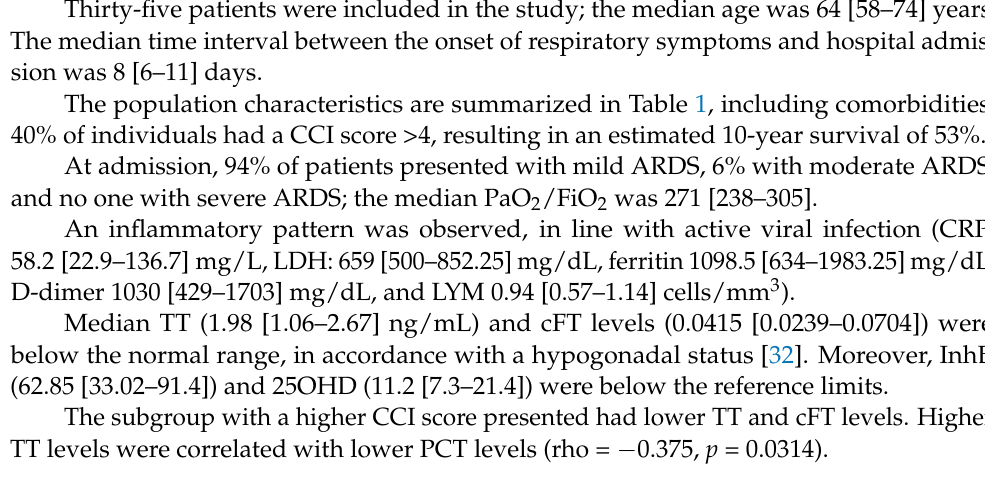
Table 1. Demographic data, comorbidities, and ARDS severity at admission of the whole